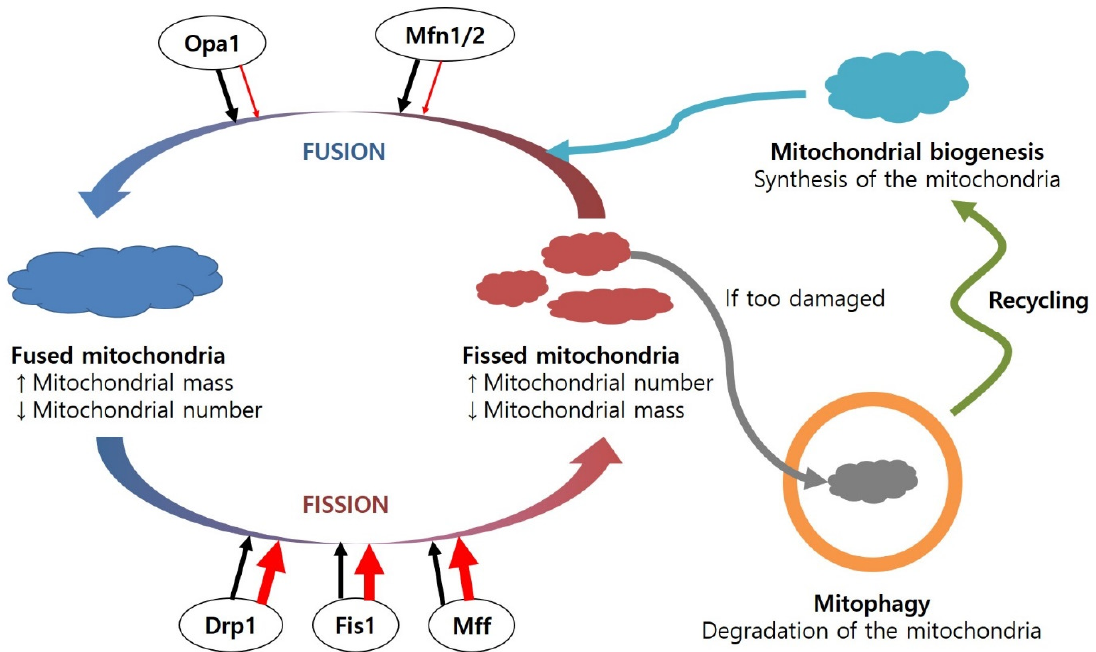
Figure 3. Regulation of the fusion and fission cycle in the mitochondria, including mitochondrial biogenesis and mitophagy. The mitochondrial fusion/fission cycle is balanced under healthy conditions. However, under diseased conditions, the levels of fusion proteins are decreased, while amounts of fission proteins are increased, resulting in a number of dysfunctional mitochondria. Damaged mitochondria can be combined with lysosomes and degraded. Abbreviations: Drp1, dynamin-related protein 1; Fis1, mitochondrial fission protein 1; Mff, mitochondrial fission factor; Mfn1/2, mitofucin 1/2; Opa1, optic atrophy protein 1.